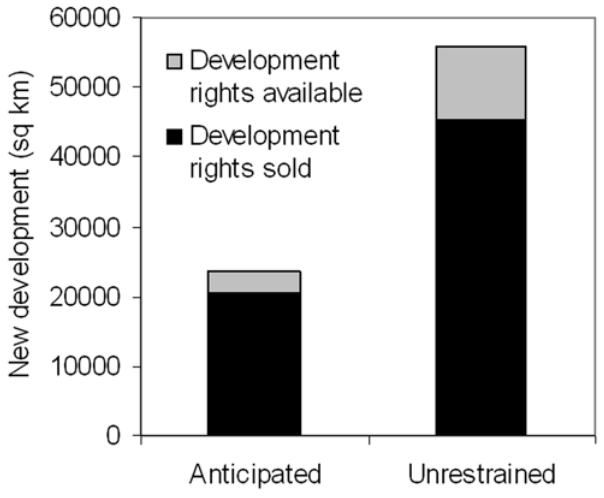
Figure 3. Area of expected development for each scenario. Area (sq km) is divided into development rights sold (black) and development rights available (light gray).